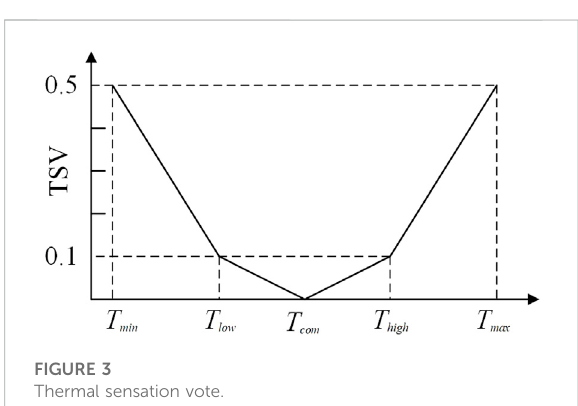
FIGURE 3 Thermal sensation